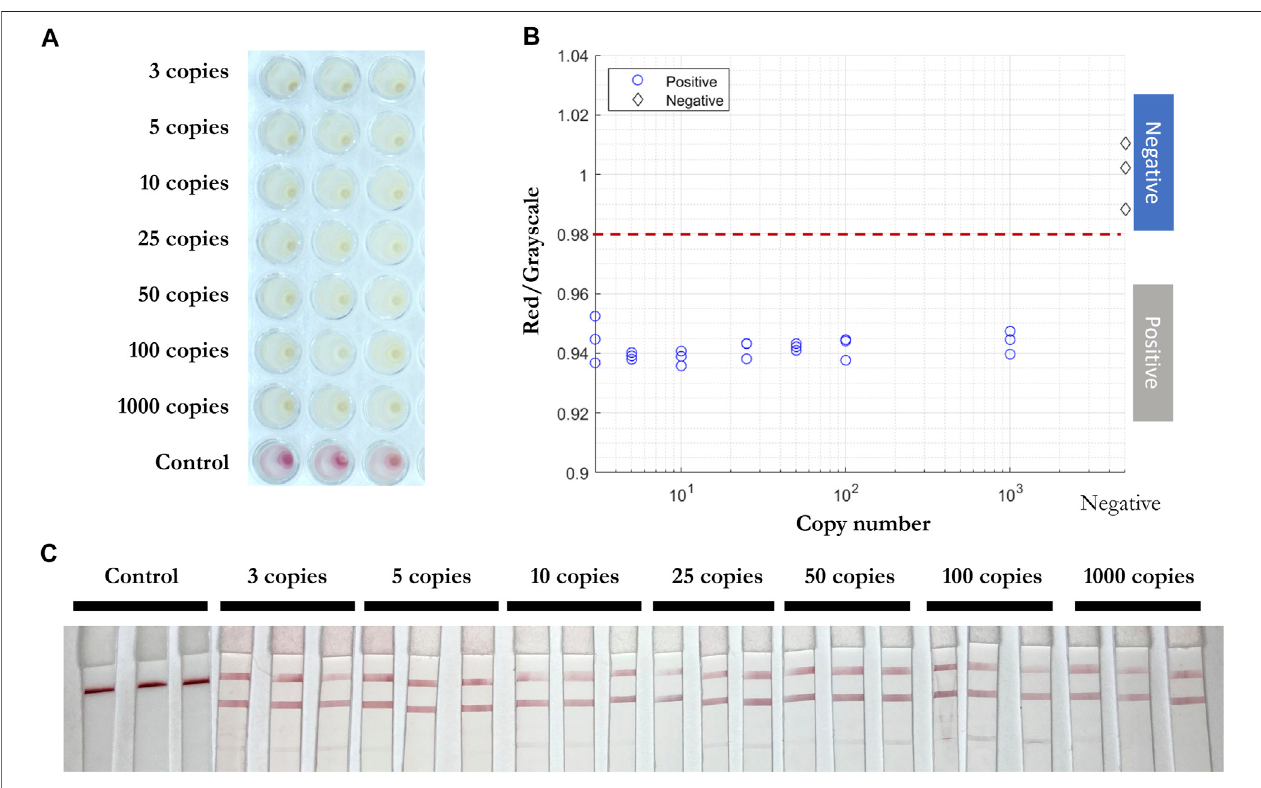
FIGURE 7 | Direct RT-LAMP-LFIA testing of inactivated viral particles without prior RNA puri fi cation or extraction. (A) RT-LAMP products for inactivated viral particles (3, 5, 10, 25, 50, 100, and 1,000 copies) and negative control samples with three sets of primers, taken by overview camera. (B) Red/grayscale vs. copy numbers of both positive and negative samples. (C) LFIA read-outs for RT-LAMP products ampli fi ed for all three